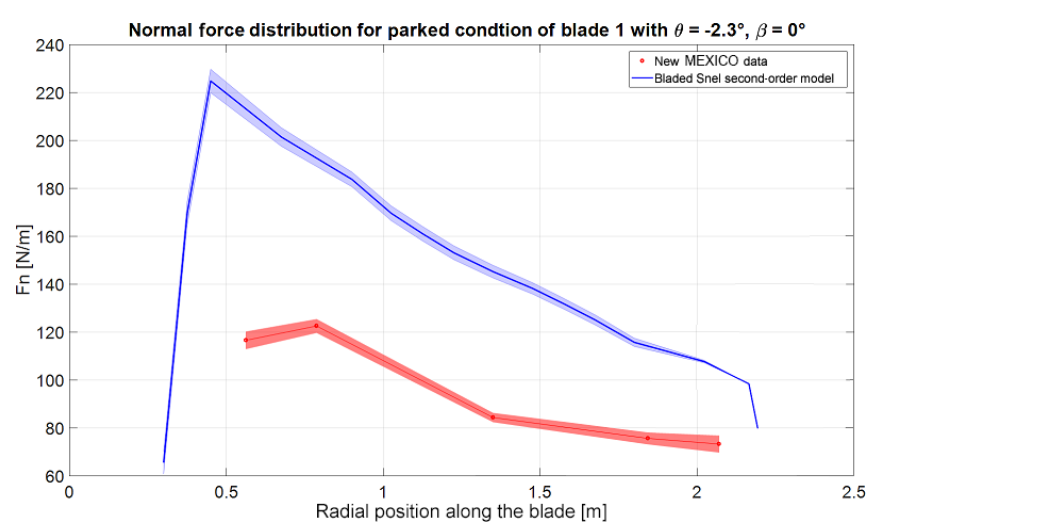
Figure 13. Normal force distribution of the blade at 0 ◦ azimuth with − 2 . 3 ◦ pitch and 0 ◦ wind direction. The bold line represents the mean value, and the shaded area is the standard